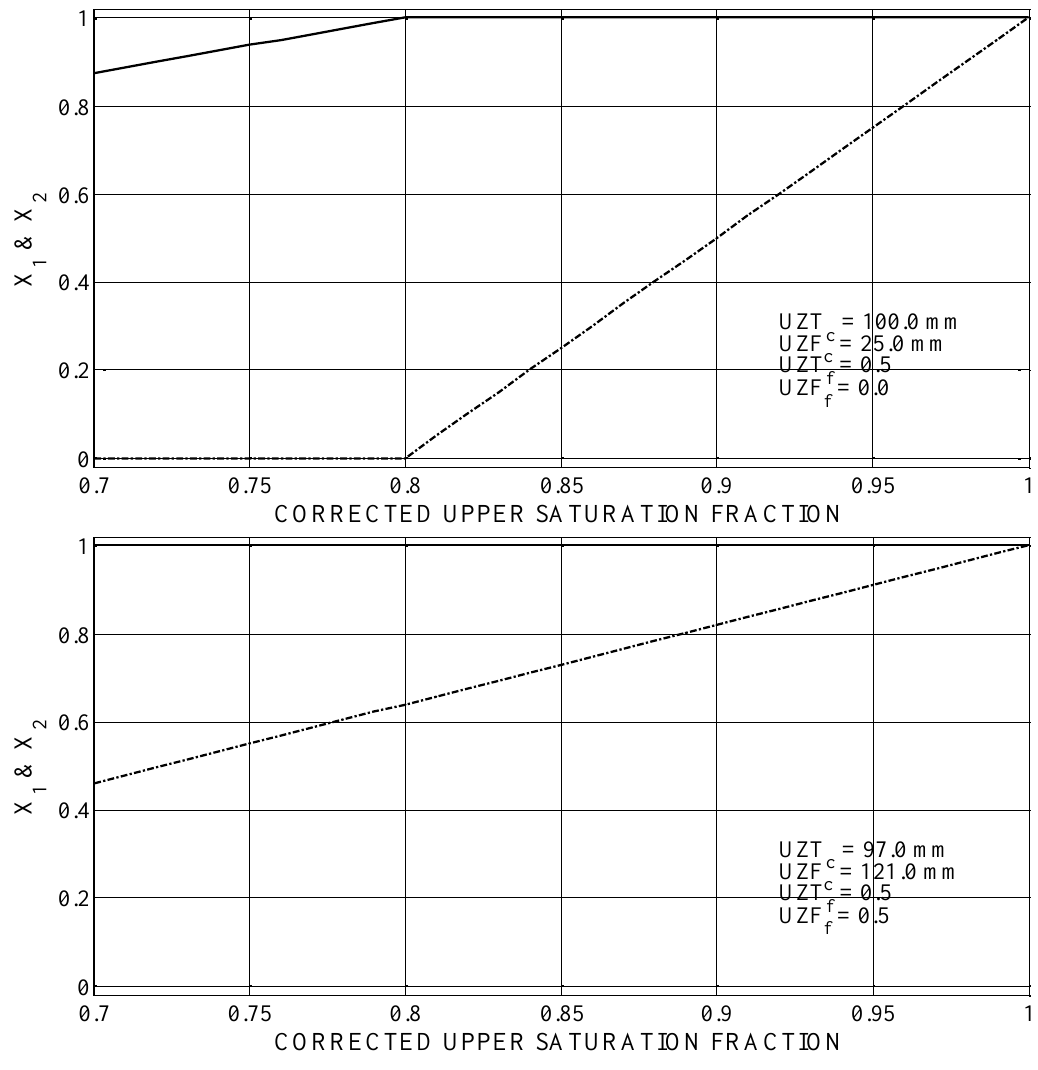
Figure 5. Solutions of the Equations (25) and (26) as functions of the mean corrected model upper soil saturation fraction, E { w’ }, for two different catchment parameters and model saturation fractions. Solid line is for X1 and dashed line is for